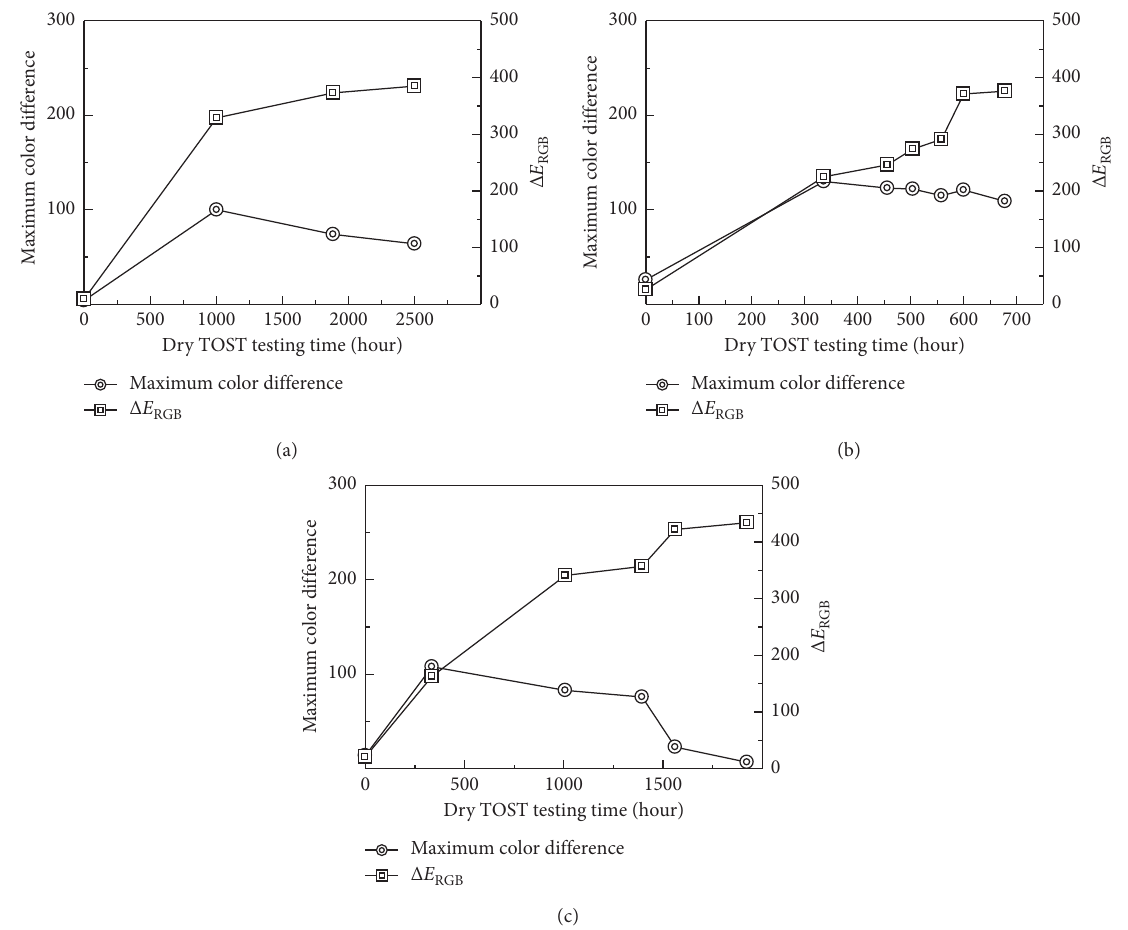
Figure 5: Relationship between dry TOST testing time, the maximum color difference, and Δ E Sample oil